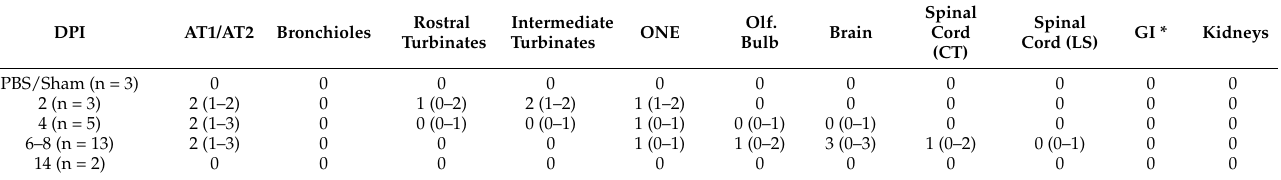
Table 3. SARS-CoV-2 viral protein abundance in tissues derived from SARS-CoV-2-infected K18- hACE2 mice. Median scores are represented along with ranges between brackets when applicable. DPI AT1/AT2 Bronchioles Rostral Turbinates Intermediate Turbinates ONE Olf. Bulb Brain